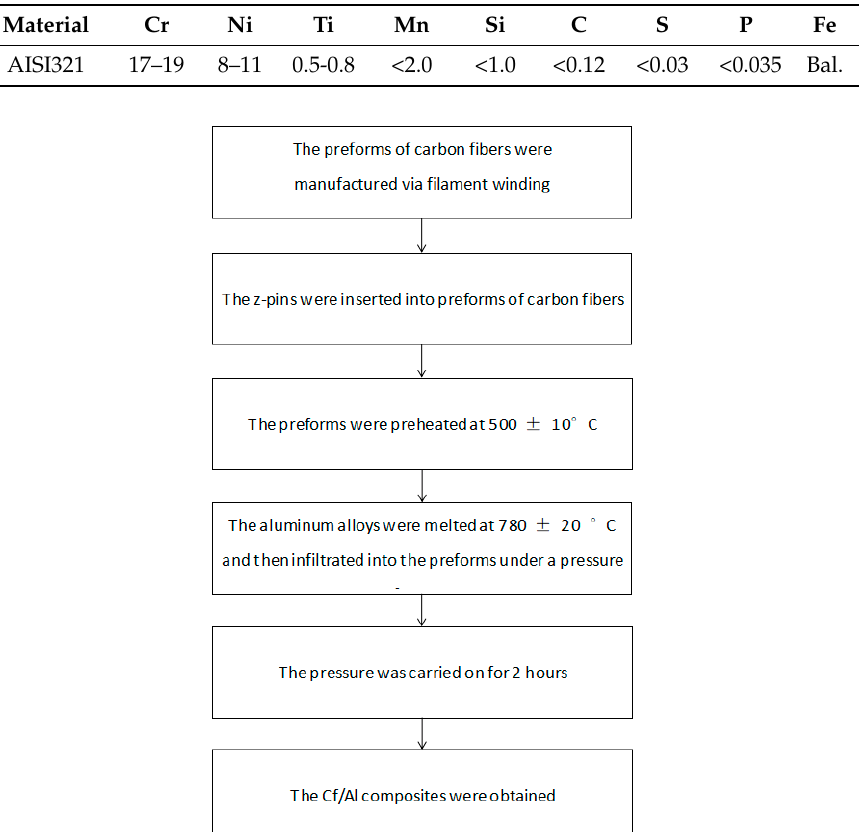
Figure 1. The flow chart of the manufacturing process of investigated composites.